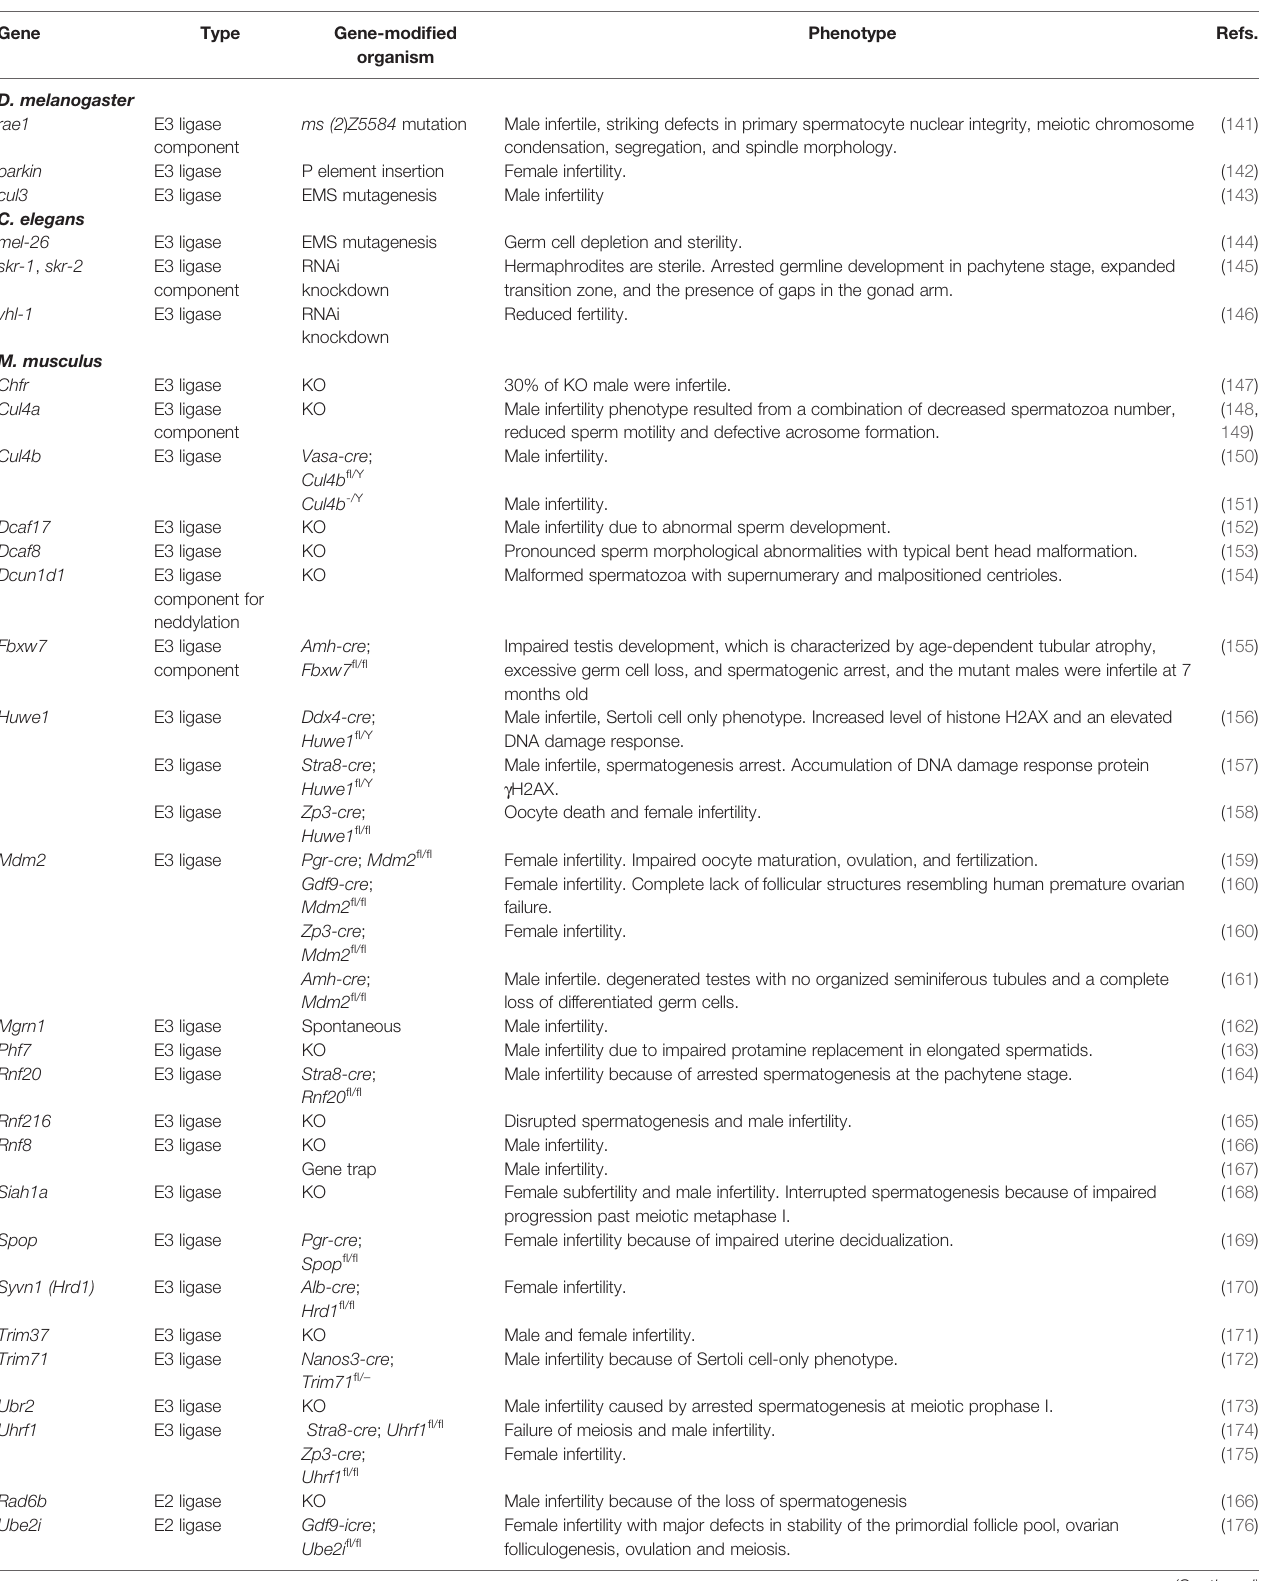
TABLE 2 | The ubiquitin ligases indispensable for mammalian